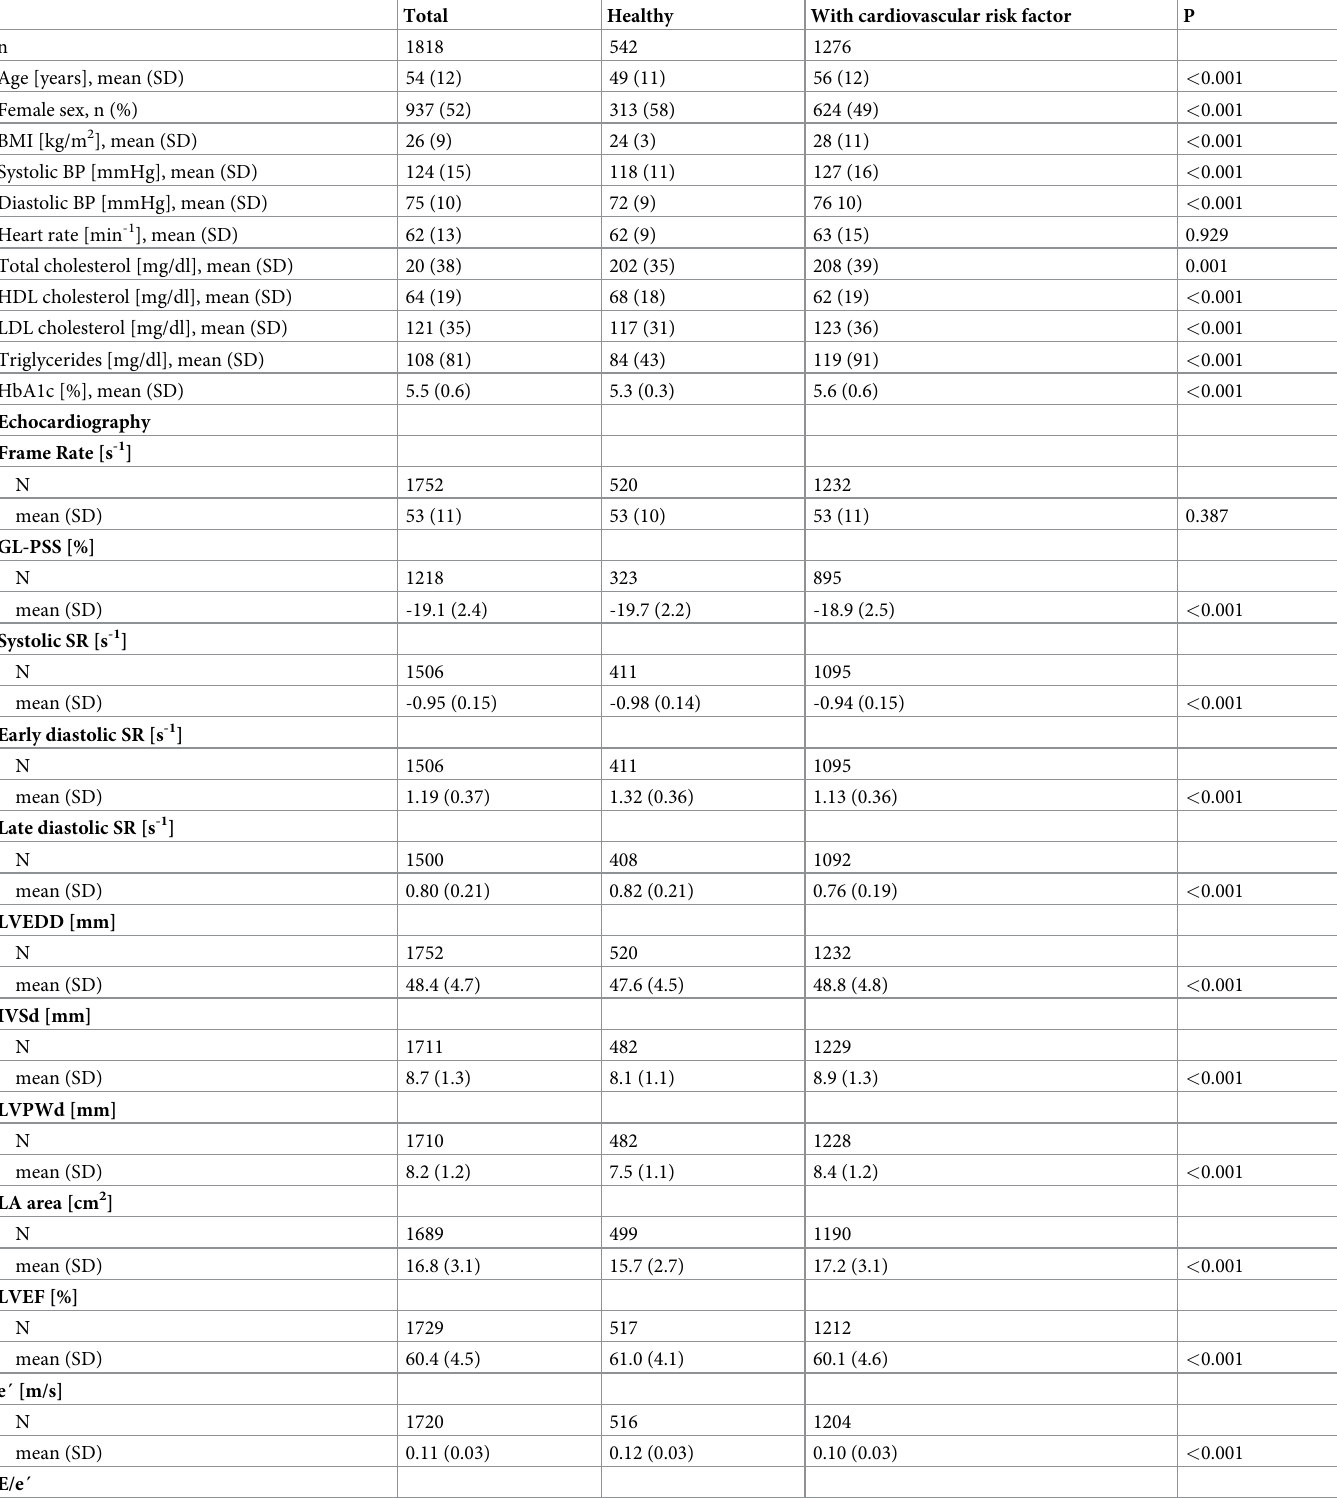
Table 1. Clinical and echocardiographic characteristics of study participants, and subgroups without and with cardiovascular risk